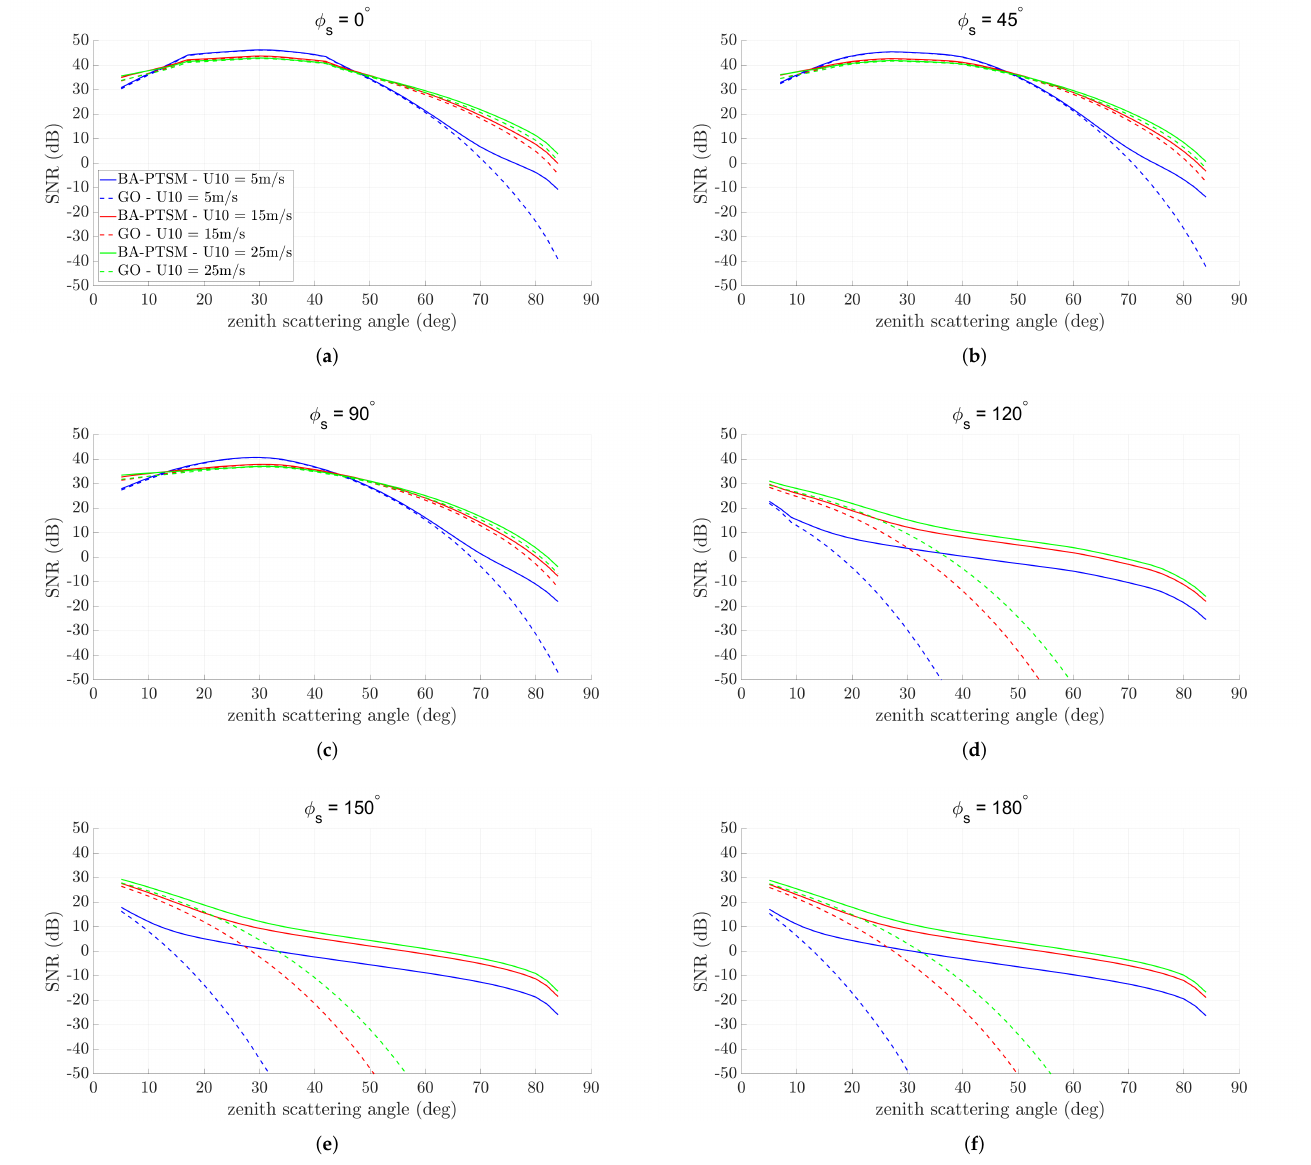
Figure 5. SNR in RL polarization for an airborne GNSS-R receiver obtained using BA-PTSM (solid lines) and GO (dashed lines) for wind speed 5 m/s (blue lines), 15 m/s (red lines), and 25 m/s (green lines). ( a ) φ s = 0 ◦ ; ( b ) φ s = 45 ◦ ; ( c ) φ s = 90 ◦ ; ( d ) φ s = 120 ◦ ; ( e ) φ s = 150 ◦ ; ( f ) φ s = 180 ◦